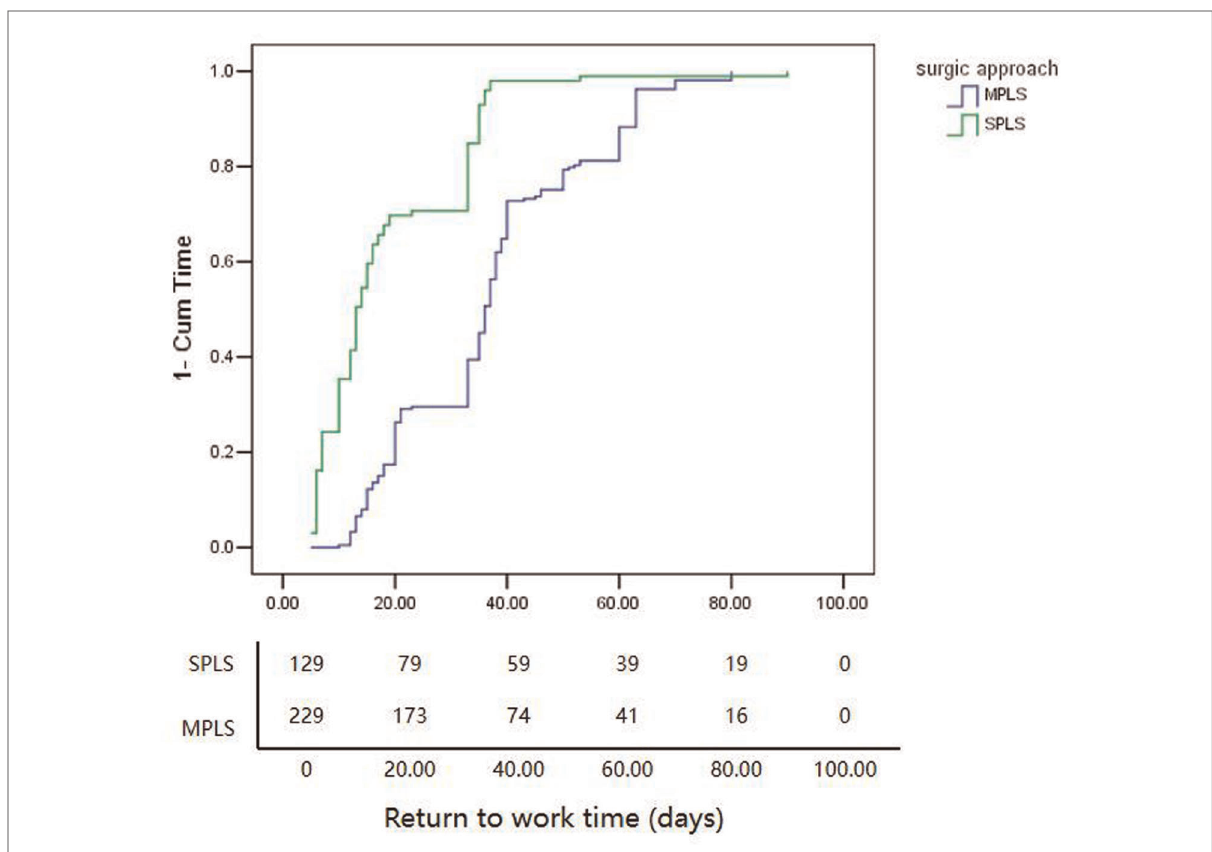
FIGURE 1 The magnitude of SPLS for RTW. The estimated medium time of RTW in the SPLS group was signi fi cantly shorter than those in the MPLS group (18.6 days vs 37.0 days, P <0.001). SPLS, single-port laparoscopic surgery; RTW, return to work